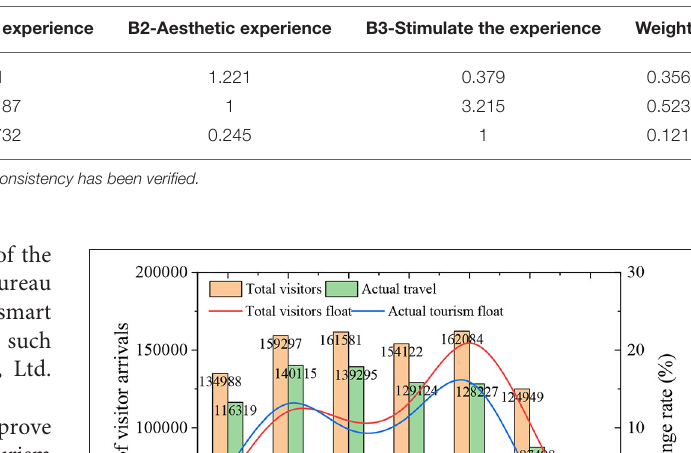
rules, the system accurately counts the total number of tourists entering Macau. Changes in the number of tourists during 1 week are as follows: the number of tourists begins to increase on